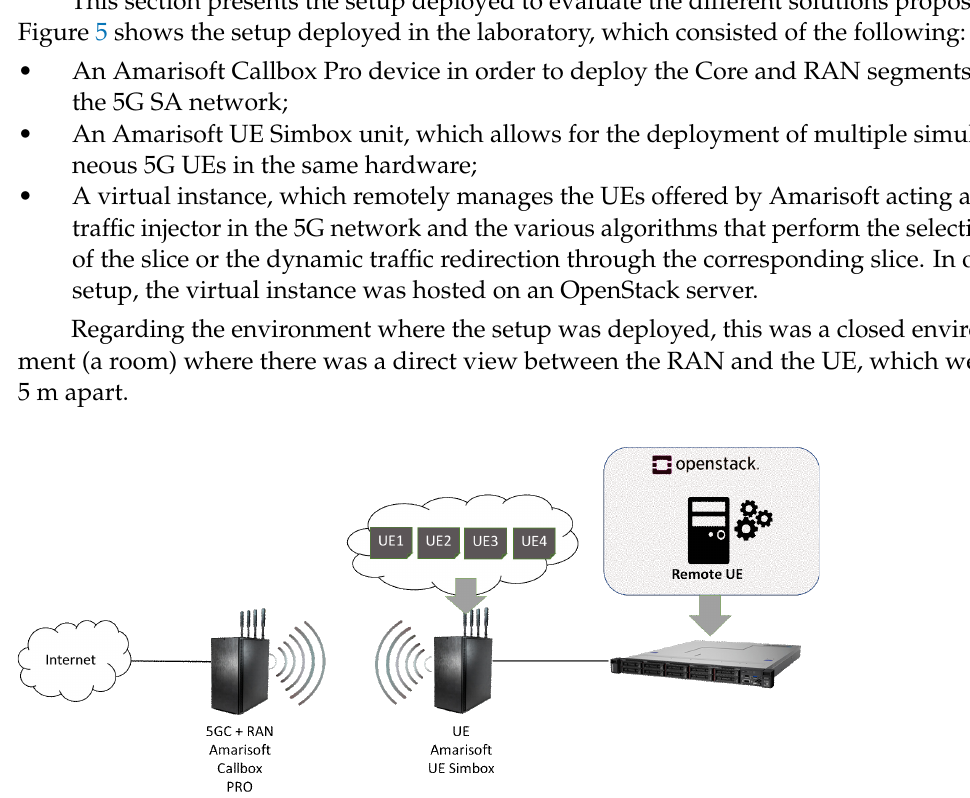
Figure 5. Experimental setup in the